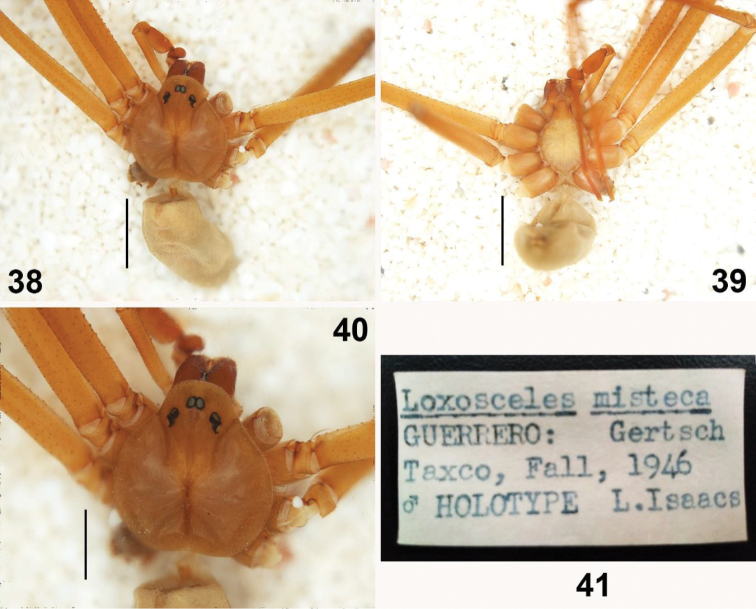
Male holotype (examined) of Loxosceles
misteca Gertsch, 1958 (AMNH_IZC 00327631), from Taxco, Municipality Taxco de Alarcón, Guerrero, Mexico; Date? 1946, collected in the fall, Leo Isaacs leg. 38, 39 habitus of male holotype, dorsal and ventral views, respectively 40 carapace 41 label of the holotype. Scale bars: 1 mm (38–40).